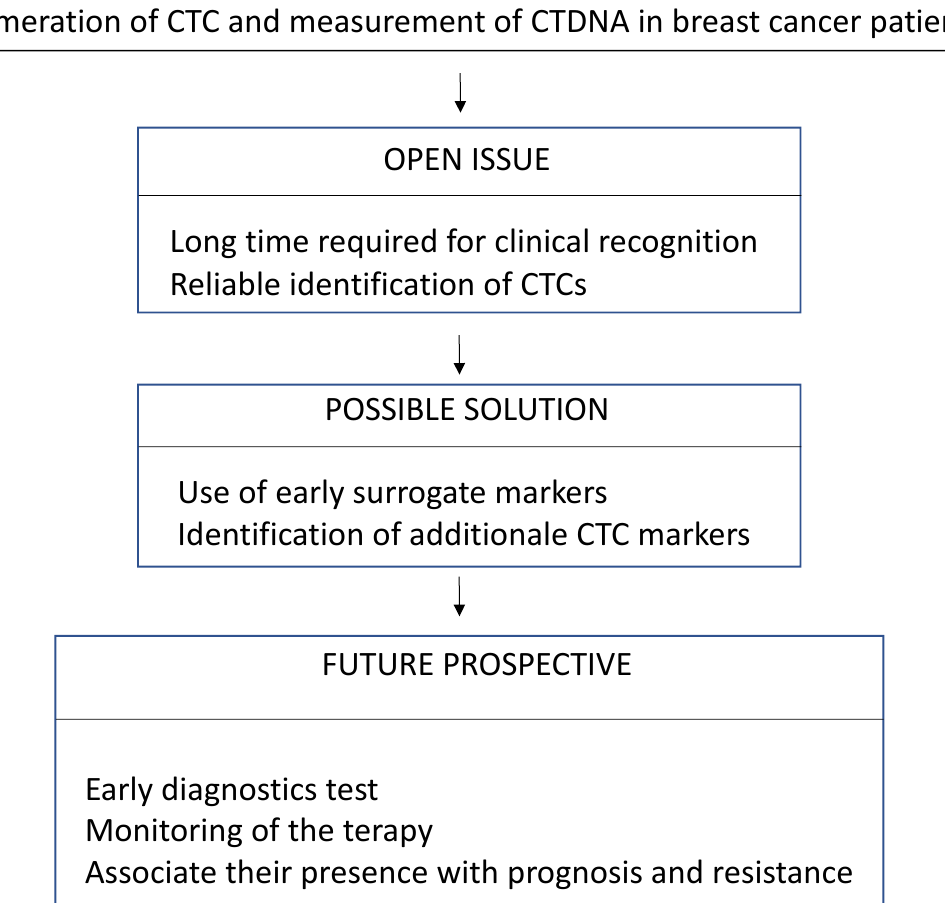
Figure 1. Pitfalls and solutions: The limitations of liquid biopsy in breast cancer detection and monitoring.